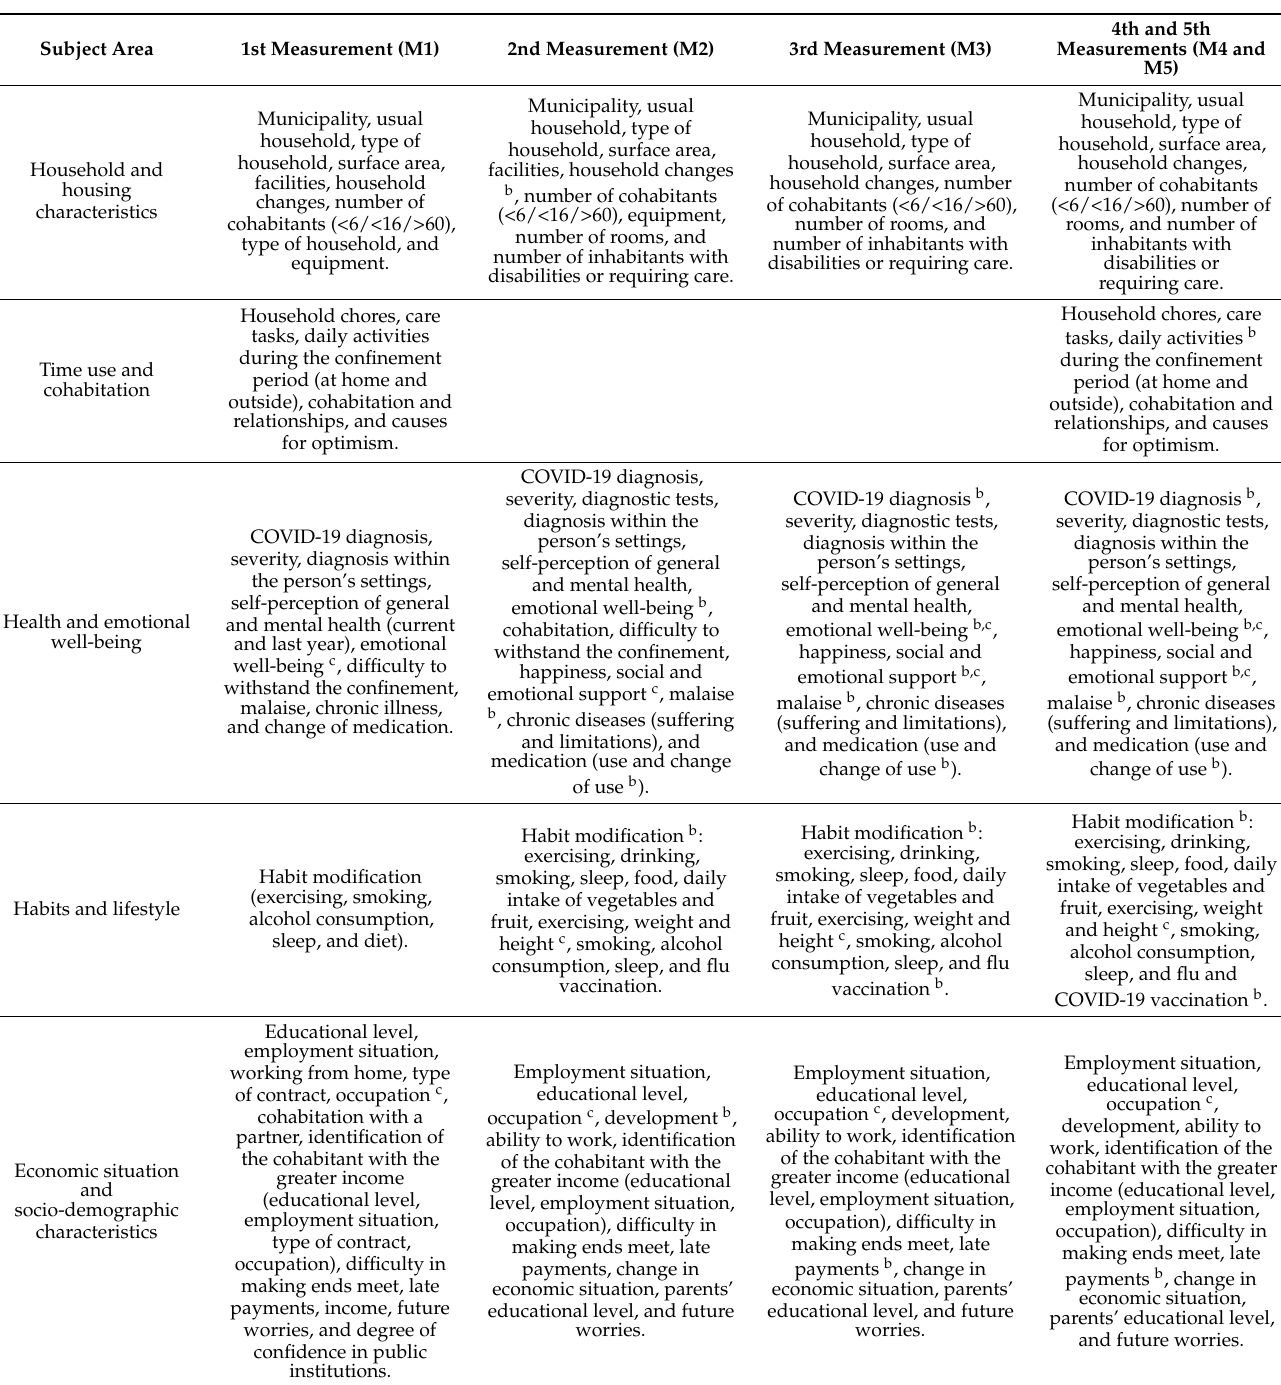
Table 5. Health Care and Social Survey (ESSOC): Information blocks and variables entered in each